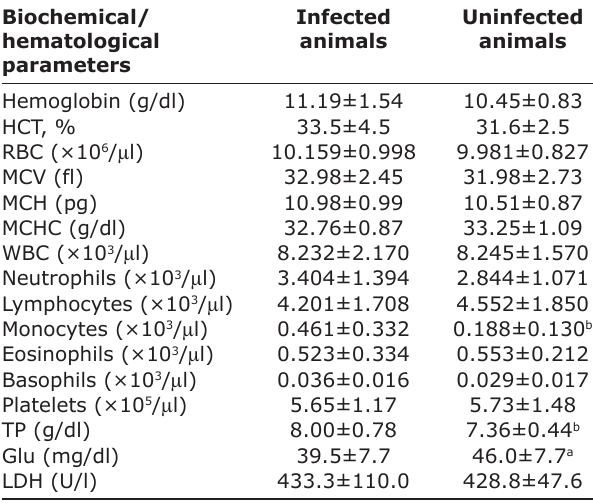
Table-3: Biochemical and hematological parameters (mean±SD) measured in infected and uninfected